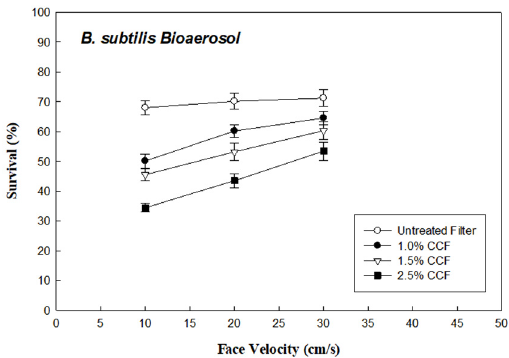
Figure 4. Survival of B. subtilis bioaerosols through the chitosan-coated and untreated